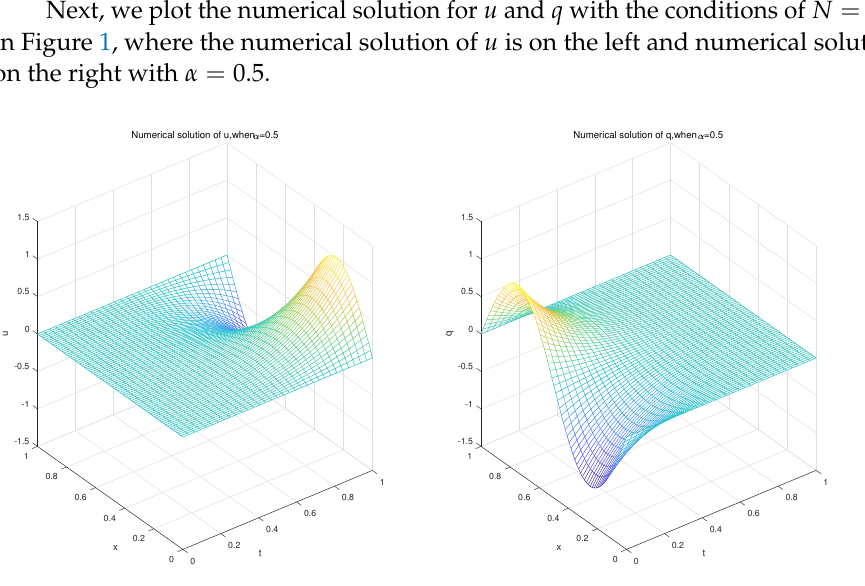
Figure 1. Numerical solution of u , α = 0.5 ( left ) and numerical solution of q , α = 0.5 ( right